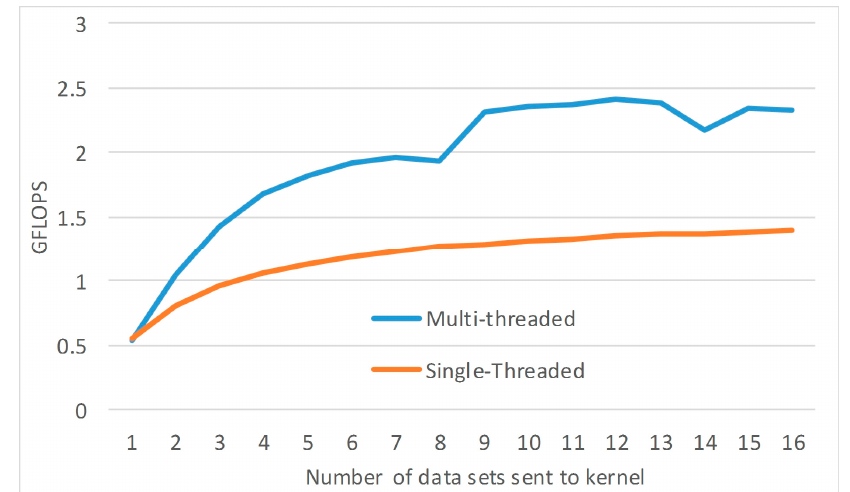
Figure 15. Beamforming kernel performance using Open Computing Language (OpenCL) (8192 range gates).